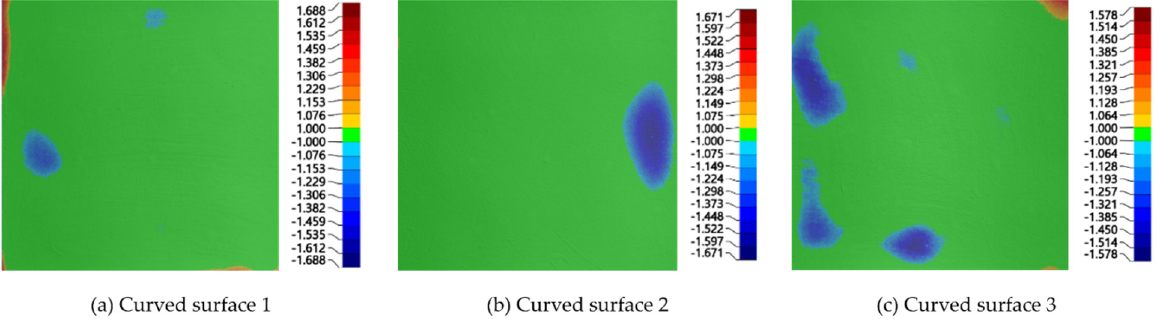
Figure 9. Shape error of detachable type.